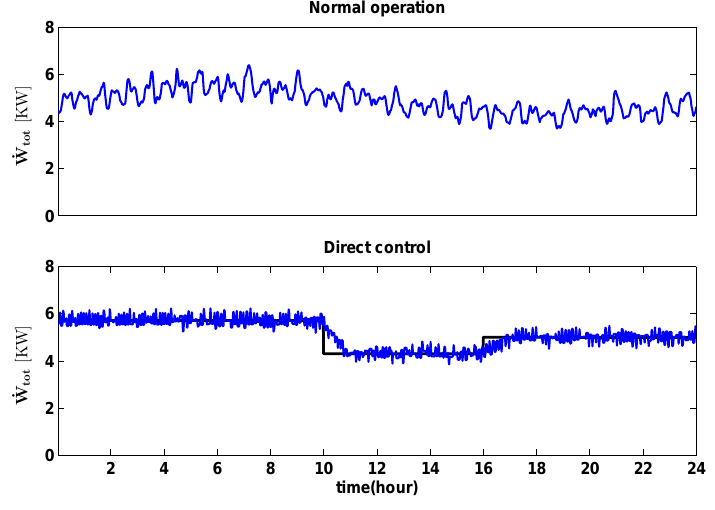
Figure 14. Power consumption for one day operation. High frequency fluctuations are mainly caused by hysteresis control of display cases. Direct control can successfully follow the reference.